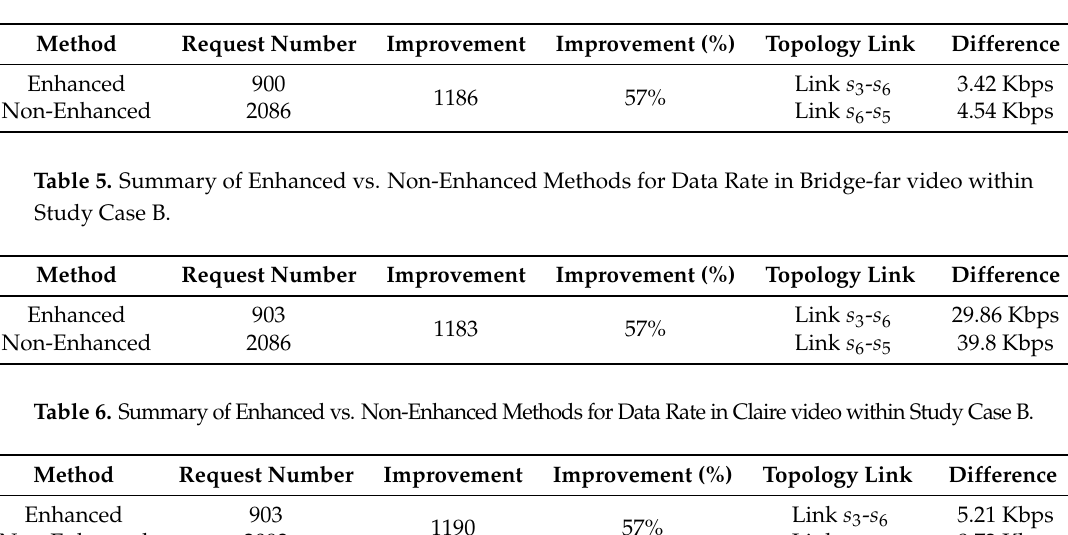
Table 4. Summary of Enhanced vs. Non-Enhanced Methods for Data Rate in Akiyo video within Study Case B.